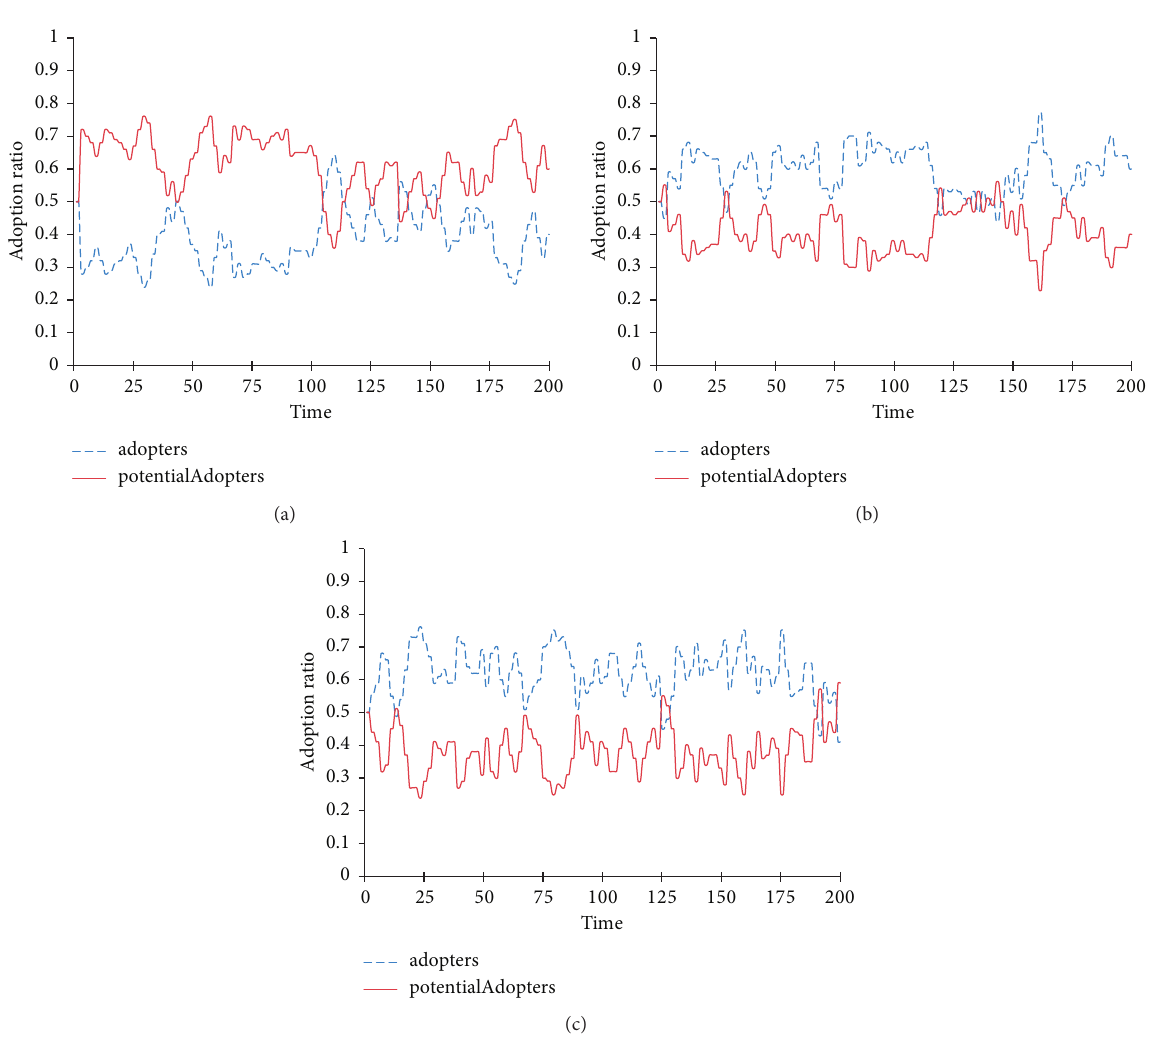
Figure 15: Effect of m on product diffusion. (a) m � 1, (b) m � 2, and (c) m �